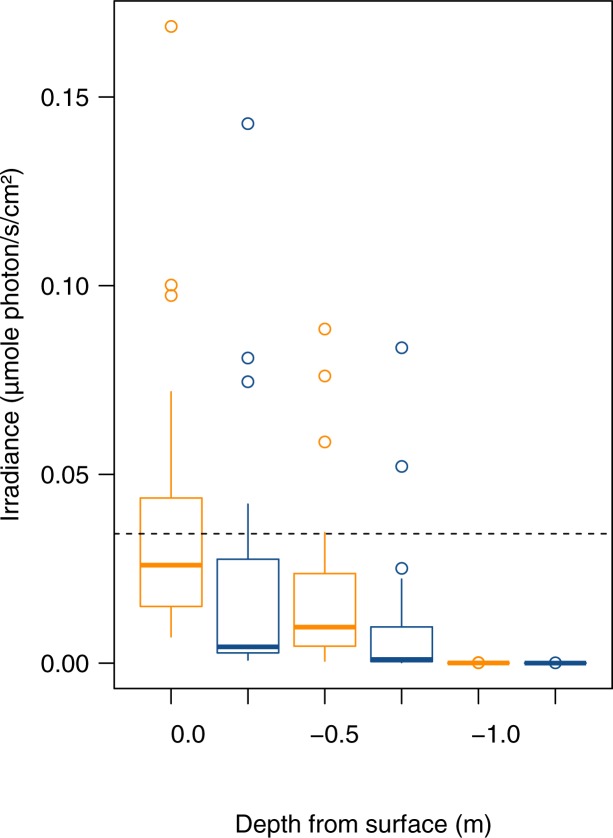
Effect of cloud cover on nocturnal light intensity in 23 freshwater urban and periurban sites.Downward irradiance (μmole/s/m2) in the 300–700 nm range measured under overcast (orange) and clear (blue) sky conditions at three elevations (above water, and underwater at -0.5 m, -1.0 m). The horizontal line shows for comparison the downward irradiance measured during a full moon and clear night on 20/07/2016.